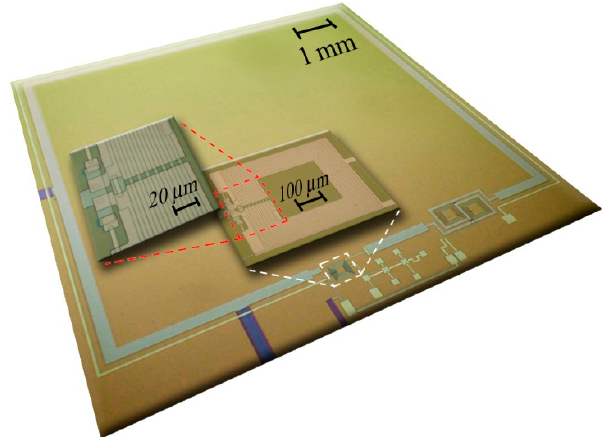
Figure 1. Fully integrated superconducting quantum interference device (SQUID) magnetometers including a bipolar coil for flux-locked-loop operation and an additional positive feedback circuit consisting of a narrow square coil (light green) surrounding the magnetometer pickup coil (light blue) and a network resistor.